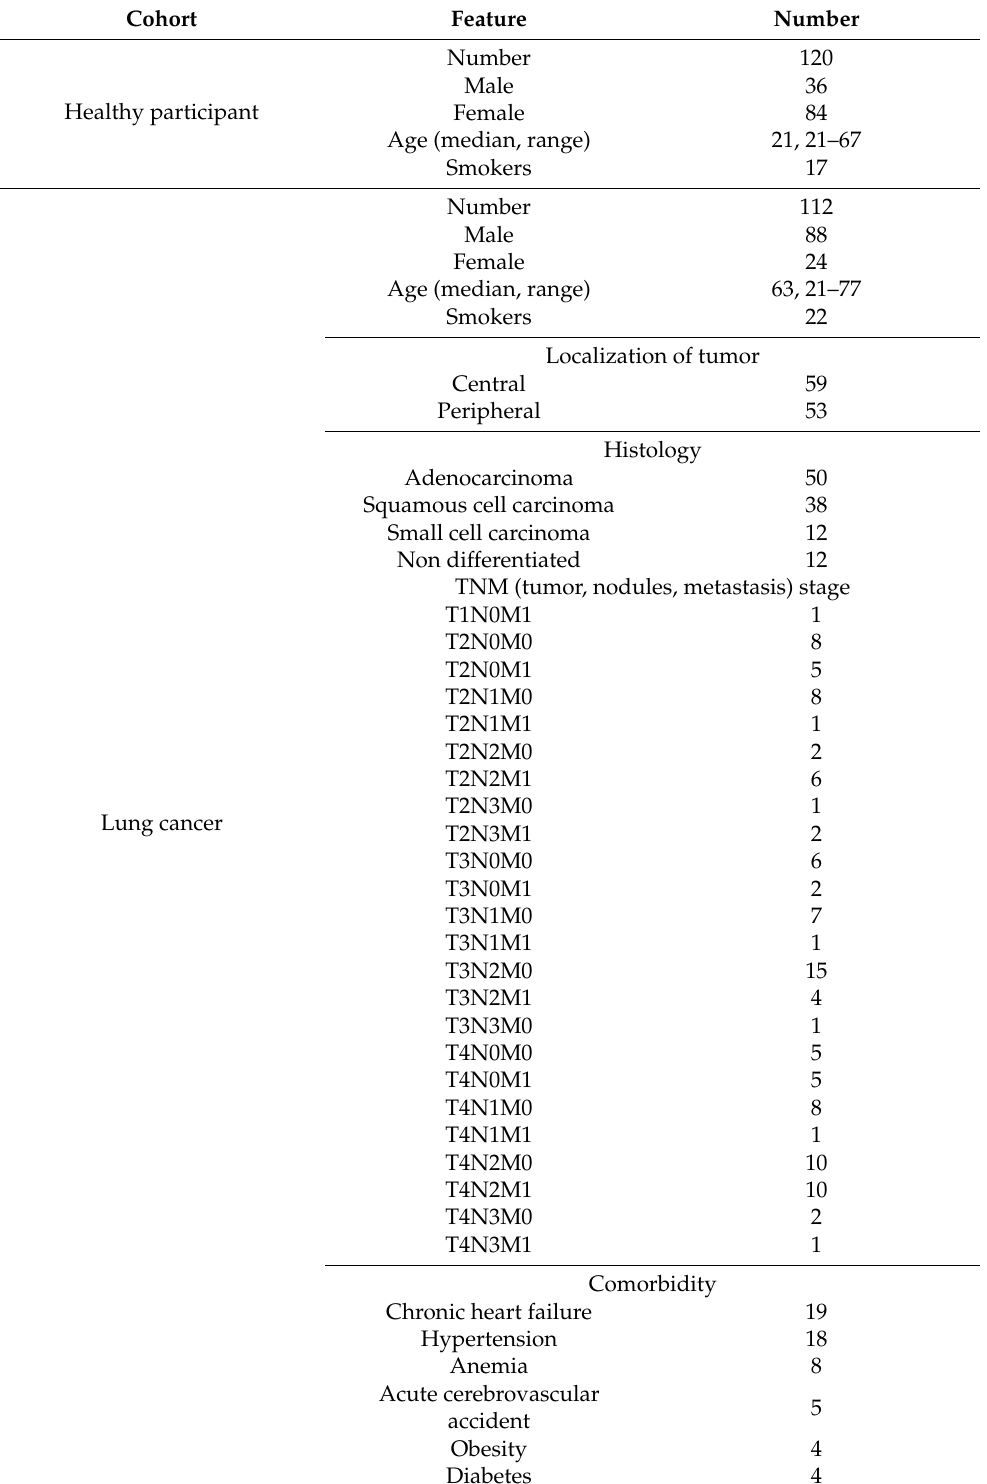
Table 1. Clinical characteristics of